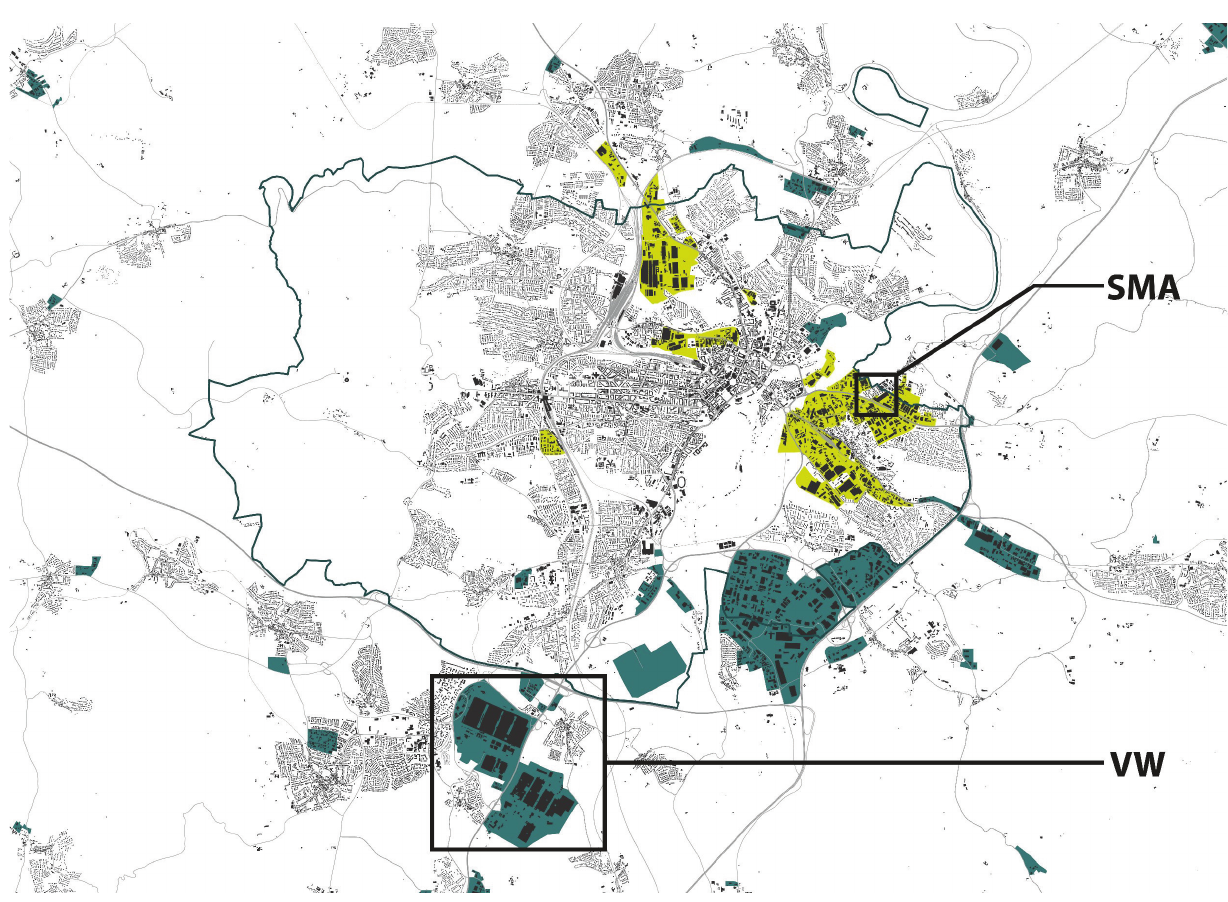
Figure 3. Existing older integrated (yellow) und suburban (green) industrial areas in the Kassel region, including the loca‐ tion of VW and SMA factories. Source: Authors’ own depiction based on a map by OpenStreetMap Contributors (2020). does not have such a long tradition in the